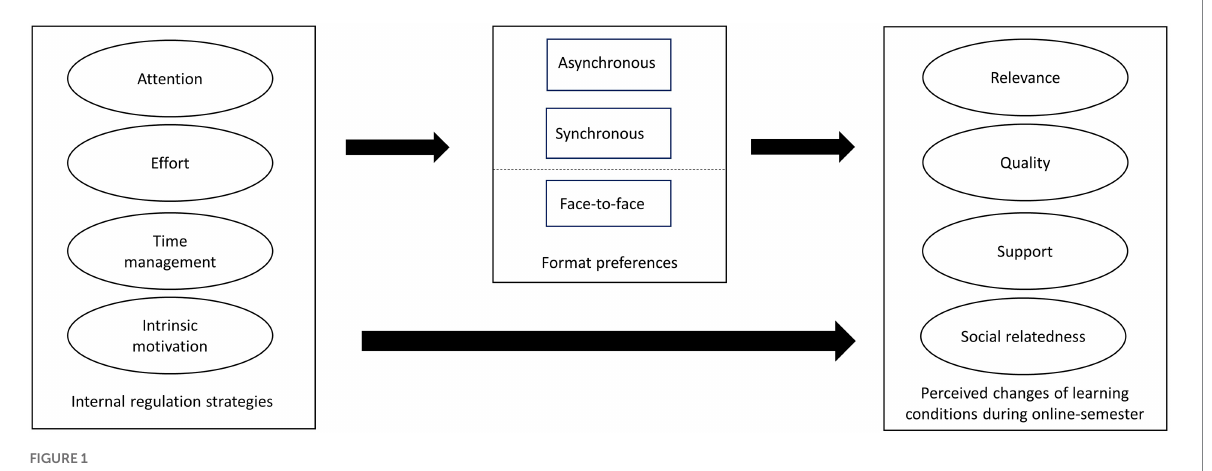
FIGURE 1 Hypothetical